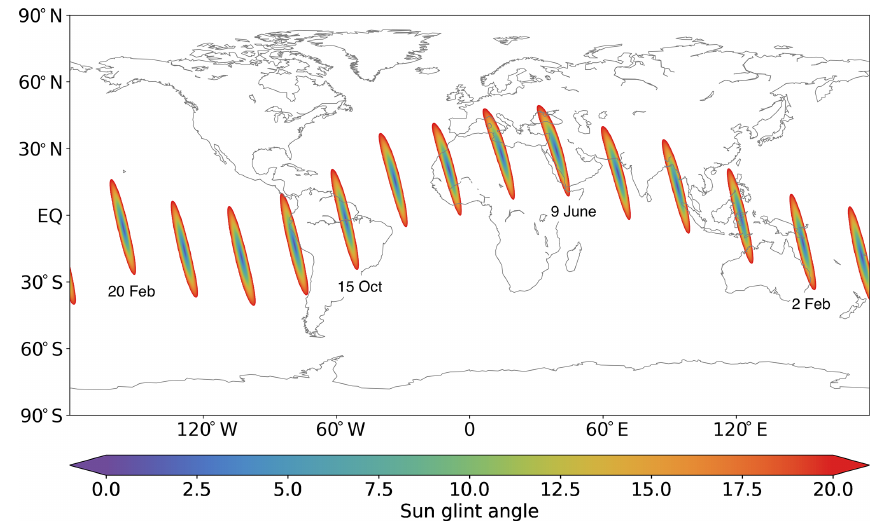
Figure A1. Sun glint angle seasonal cycle. Each coloured area corresponds to the sun glint area (i.e. SGA < 20 ◦ ) for separate orbits in different months throughout the year, starting 1 January on the easternmost orbit and increasing months towards the west.